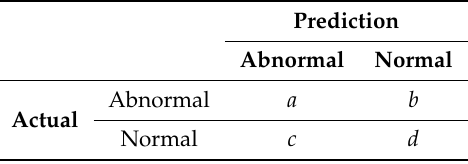
Table 1. The illustration of the confusion matrix for binary classification problem. a , b , c , and d denotes the number of true positive (TP), false negative (FN), false positive (FP) and true negative (TN), respectively. TP: actual class, anomaly (True = Yes) and prediction class, anomaly (True = Yes); FN: actual class, anomaly (True = Yes) and prediction class, normal (False = Yes); FP: actual class, normal (False = Yes) and prediction class, anomaly (True = Yes); TN: actual class, normal (False = Yes) and prediction class, normal (False = Yes).